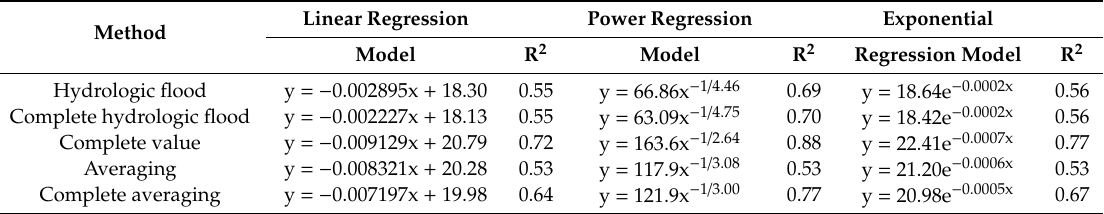
Table 2. Correlation coe ffi cients (R 2 ) for the regression models that best fitted the relationship between di ff erent discharge methods and the extent of saltwater